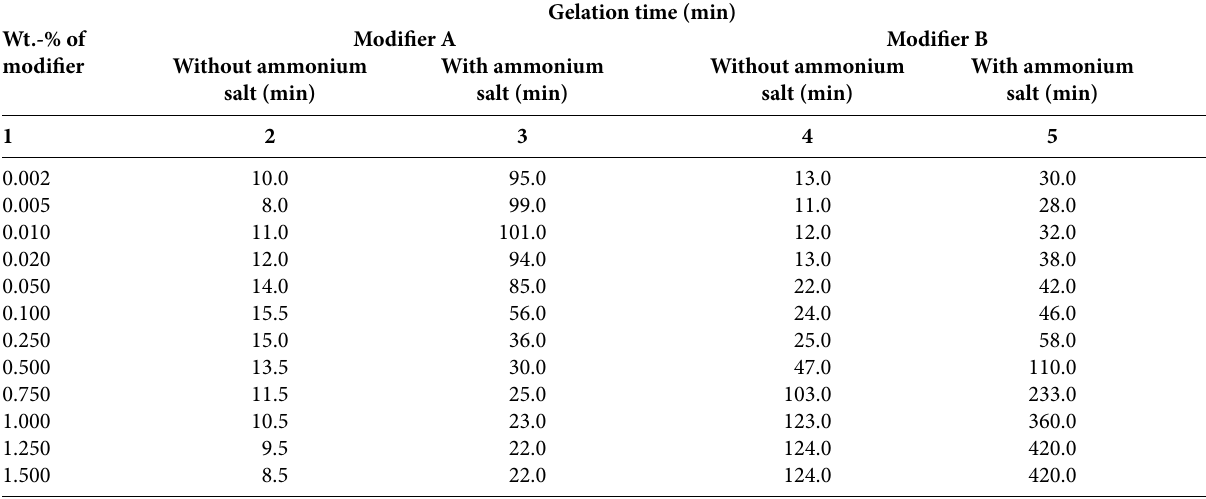
Table 6. Comparison of Gelation Times for UP Resins with Modifiers A and B Containing or Not the Benzyltriethylammonium Chloride Stabilizer Gelation time (min) Wt.-% of Modifier A Modifier B modifier